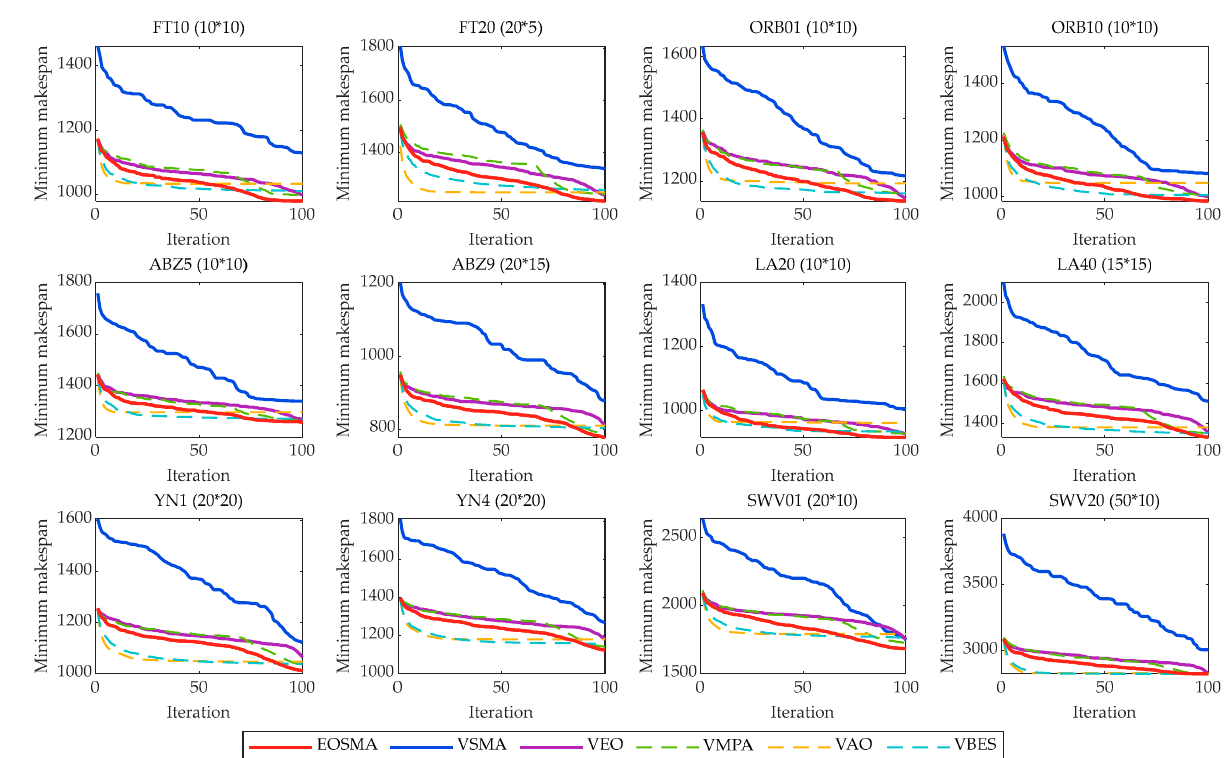
Figure 7. Average convergence curves of all comparison algorithms.